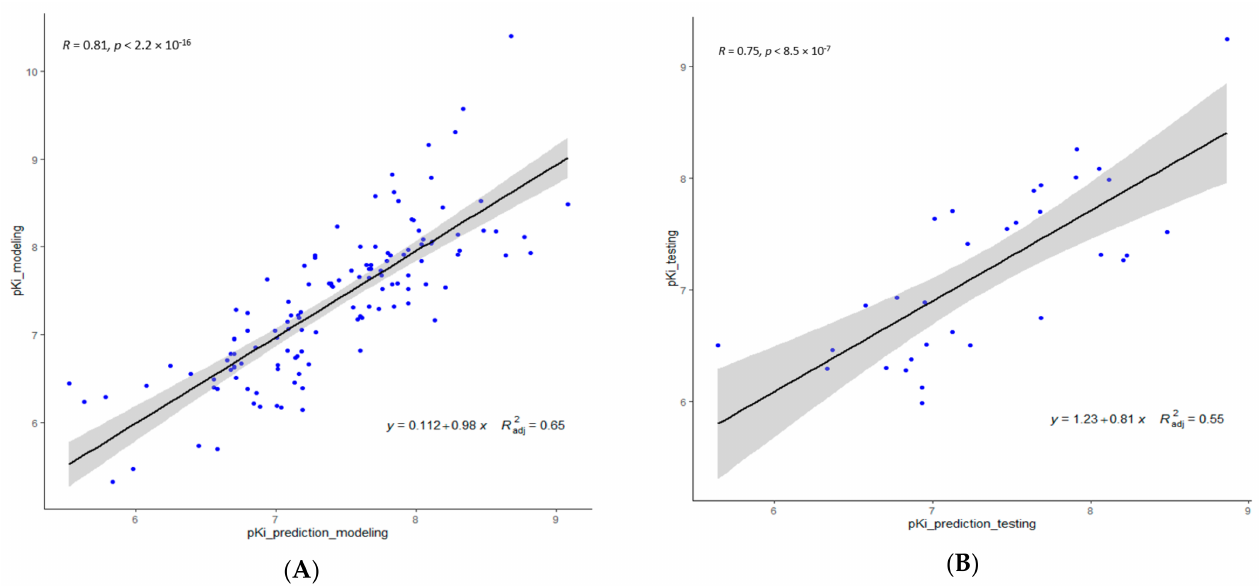
Figure 1. Linear regression plots of the 2D-QSAR model—predicted versus experimental pKi values of S2R ligands using the GreedGene descriptors: ( A ) modeling dataset; and ( B ) testing